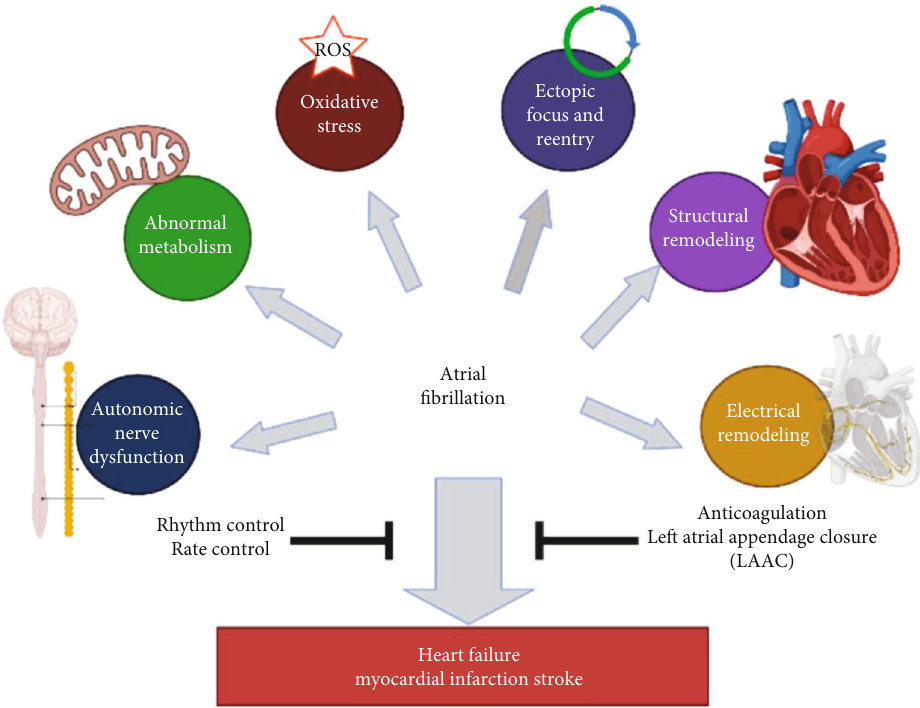
Figure 1: Pathophysiological changes, treatment, and complications of atrial fi